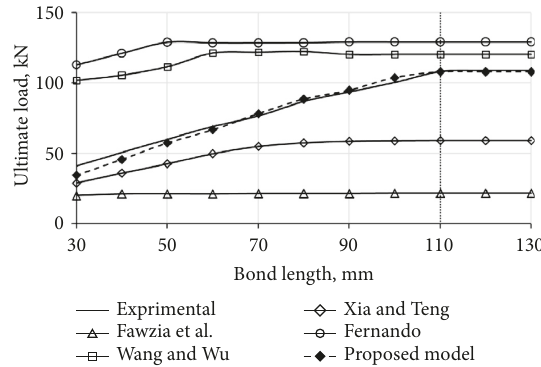
Figure 5: Ultimate load vs. bond length, comparing results from tests and FE models corresponding to existing τ –s models.